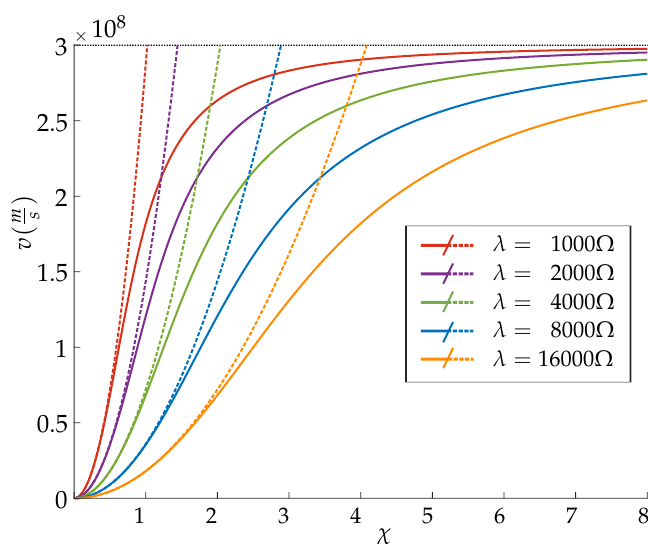
Figure 5. Stepped leader speed as a function of χ = L